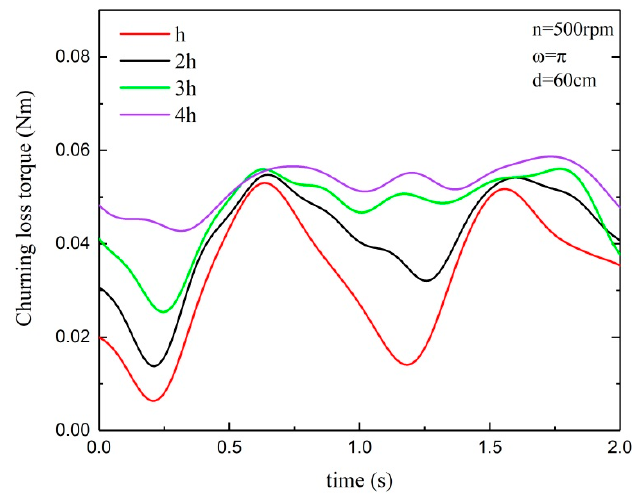
Figure 14. Churning loss torque of gears with different oil immersion depth.